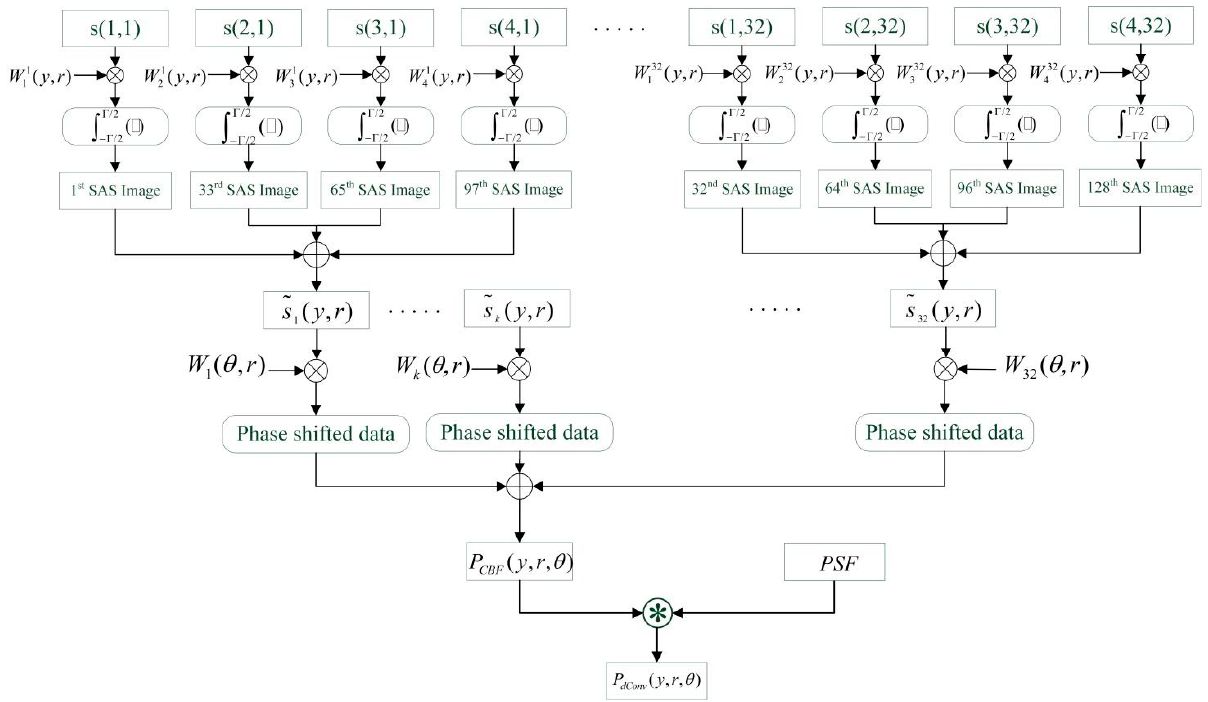
Figure 2. Processing scheme of the 3D MBSAS imaging system.